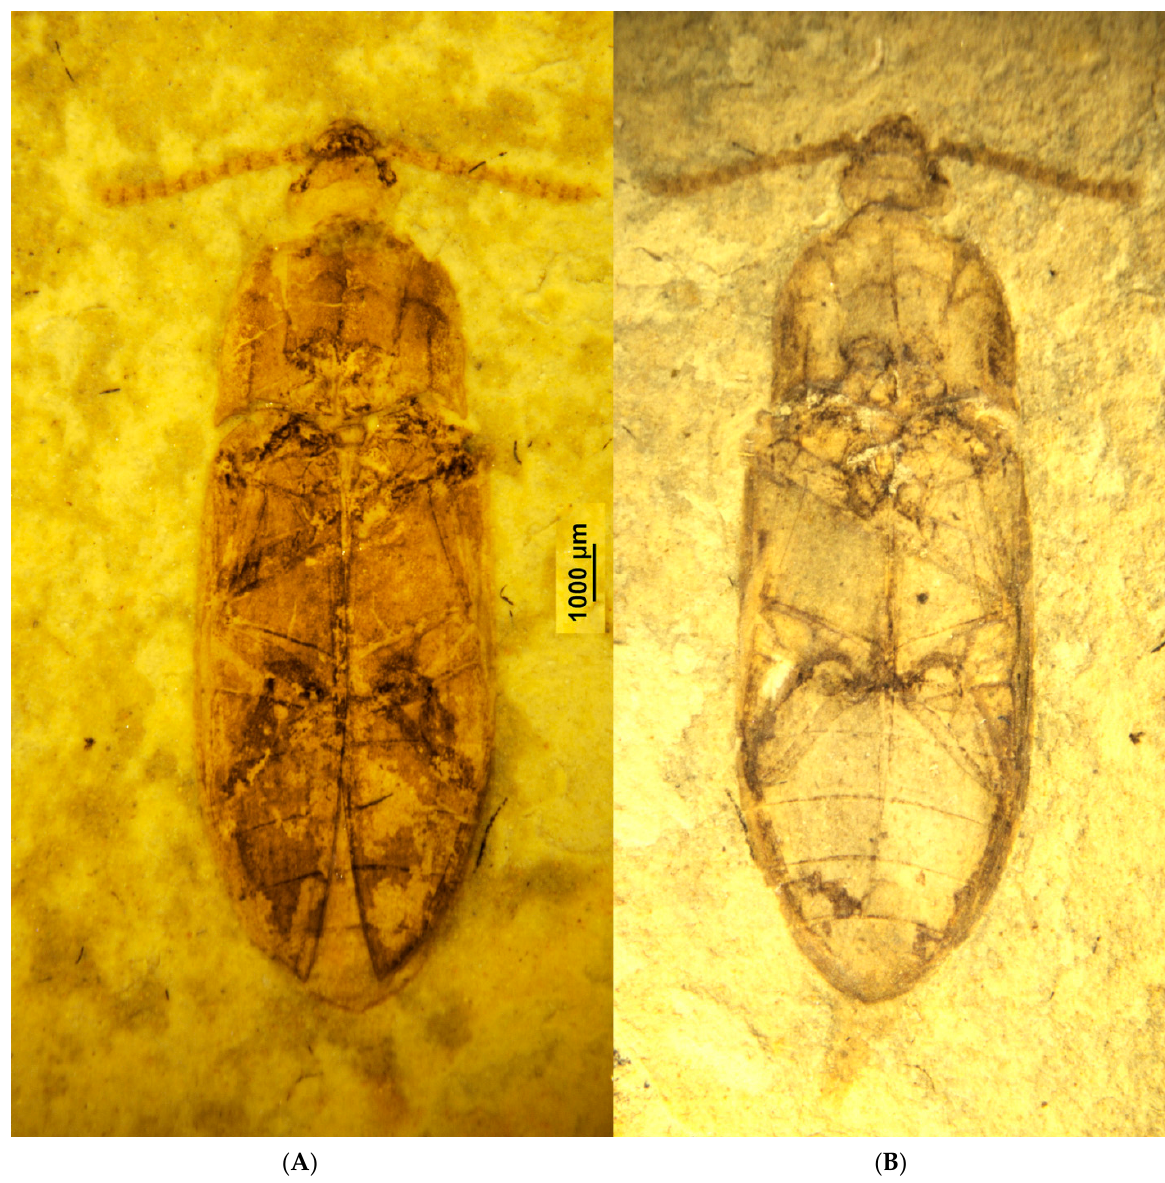
Figure 1. Rheanischia brevicornis n.sp. Holotype. ( A ) Dorsal view (2018344), ( B ) ventral view (2018344).